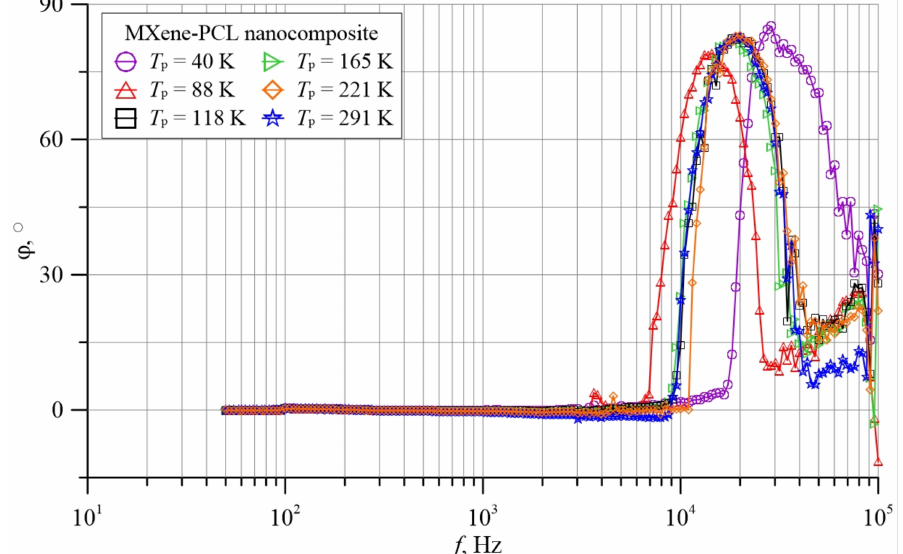
Figure 9. Frequency dependence of phase shift angle ϕ of the MXene-PCL nanocomposite for six selected temperatures measured in a parallel substitution